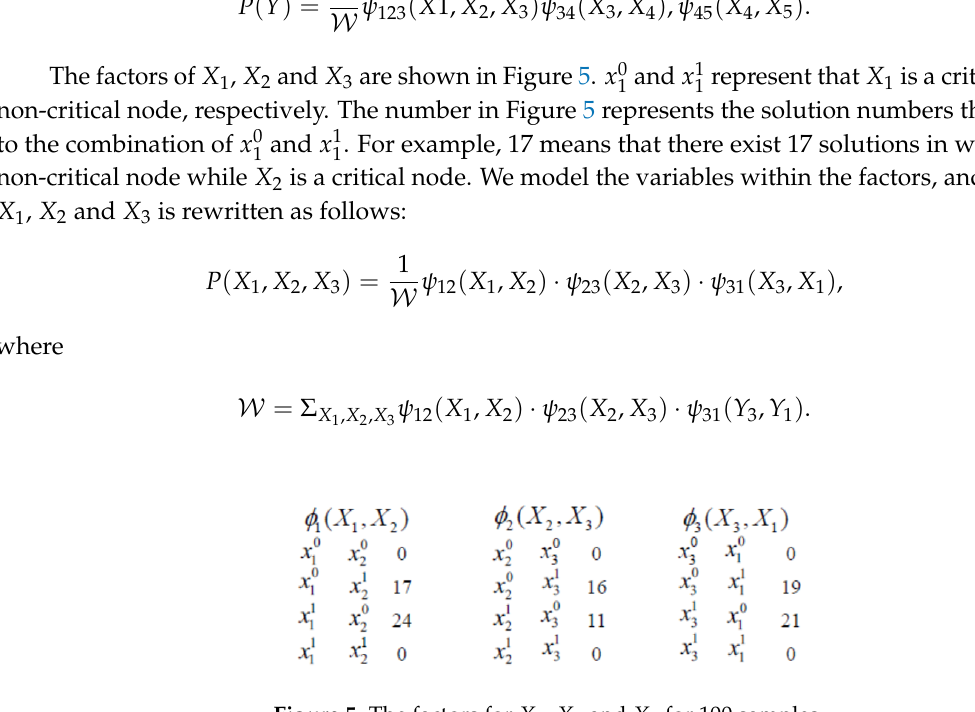
Figure 5. The factors for X 1 , X 2 and X 3 for 100